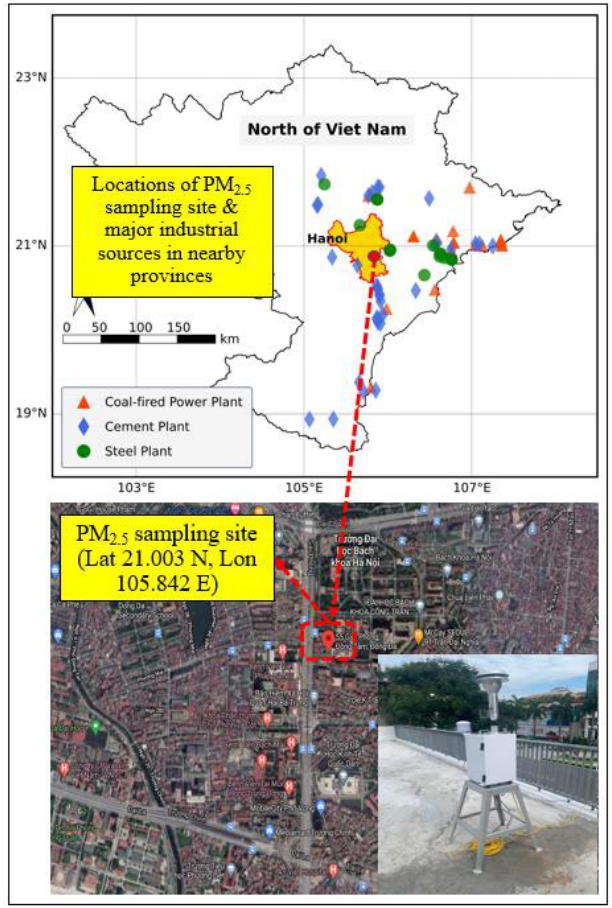
Figure 1. Study area and sampling site for PM 2.5 measurement in Hanoi, Vietnam.